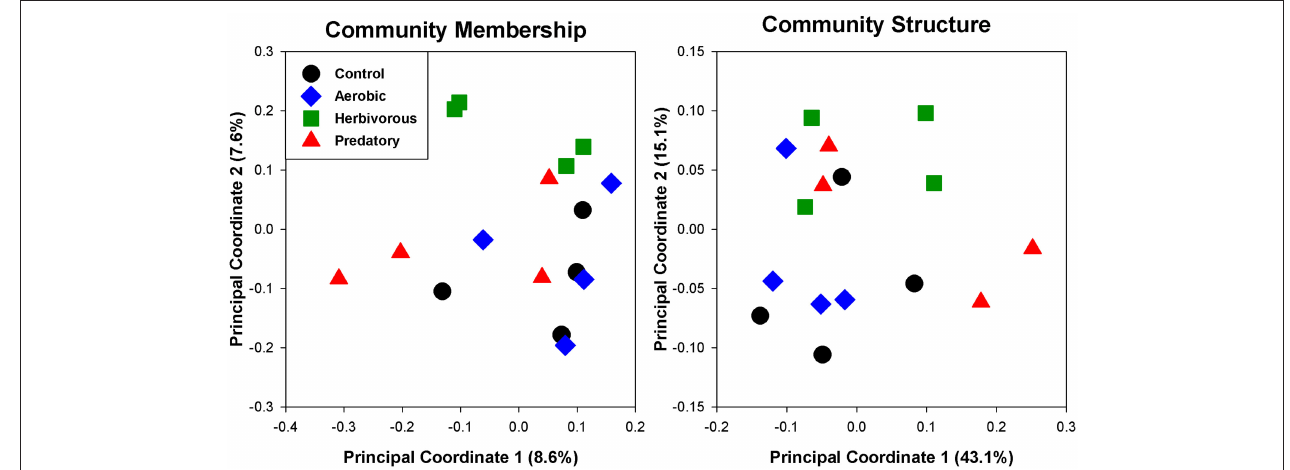
FIGURE 3 | Principal coordinate analyses of cecal communities of voles selected for various traits. Community membership uses unweighted UniFrac distances, and thus investigates the presence or absence of bacterial lineages. Community structure uses weighted UniFrac distances, which take relative abundances of taxa into account.